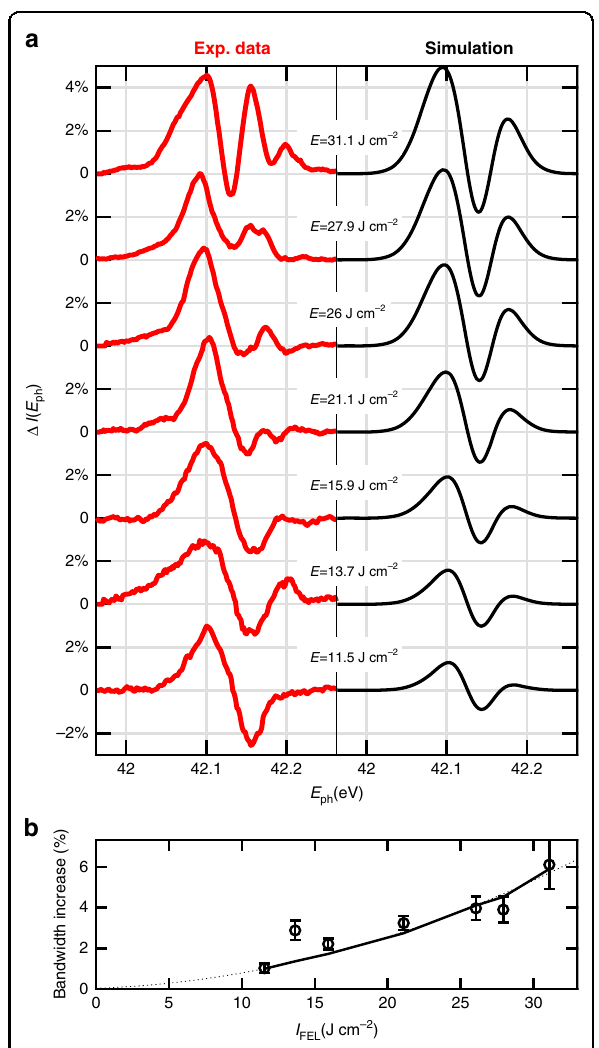
Fig. 2 Theoretical simulation of experimental results below the absorption edge. a The experimental data (red lines) reported for different FEL fl uences in 140 nm of Mg are compared with the relative simulation (black lines) of DTRE and SPM NLEs obtained from a fi tting procedure of Eq. (6). The modi fi cation of pulse intensity ( Δ I = ∣ ψ ( L , E ph ) ∣ 2 − ∣ ψ (0, E ph ) ∣ 2 ) is calculated (see Methods section). b The percentage increases of bandwidth, observed in our measurements (circles) and in the theoretical curves (solid line), are depicted. The dotted line is a parabolic guide to the